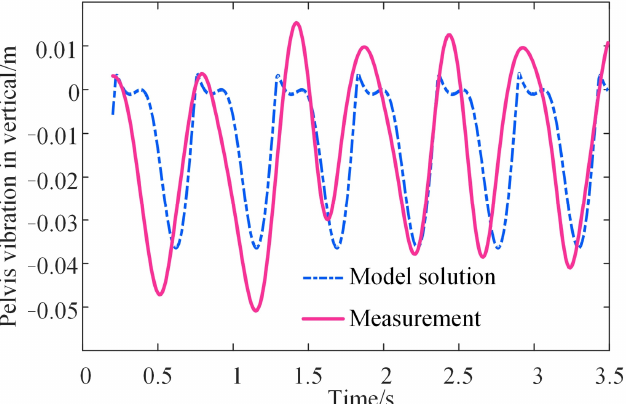
Figure 10. The pelvis trajectory calculated by the model and real measurement.